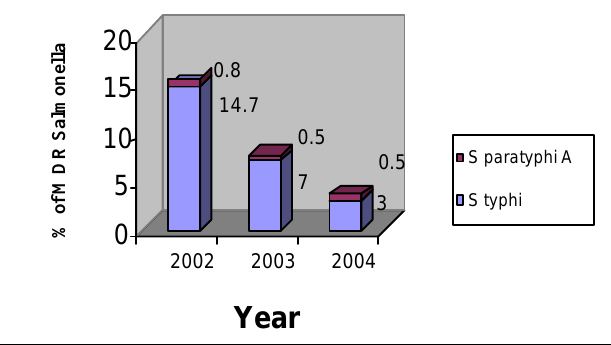
Fig. 2 : Percentage of Multi-drug resistant Salmonella typhi and paratyphi ‘A’.